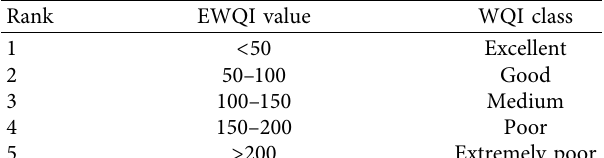
Table 2: Classification standards of groundwater quality according to EWQI.